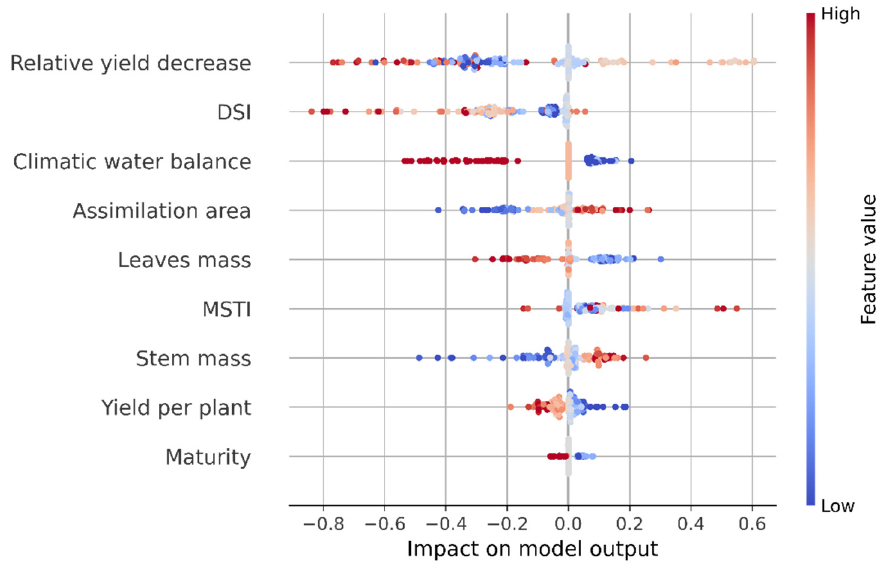
Figure 4. Local explanation summary with SHAP values for the final model (config 5) output.